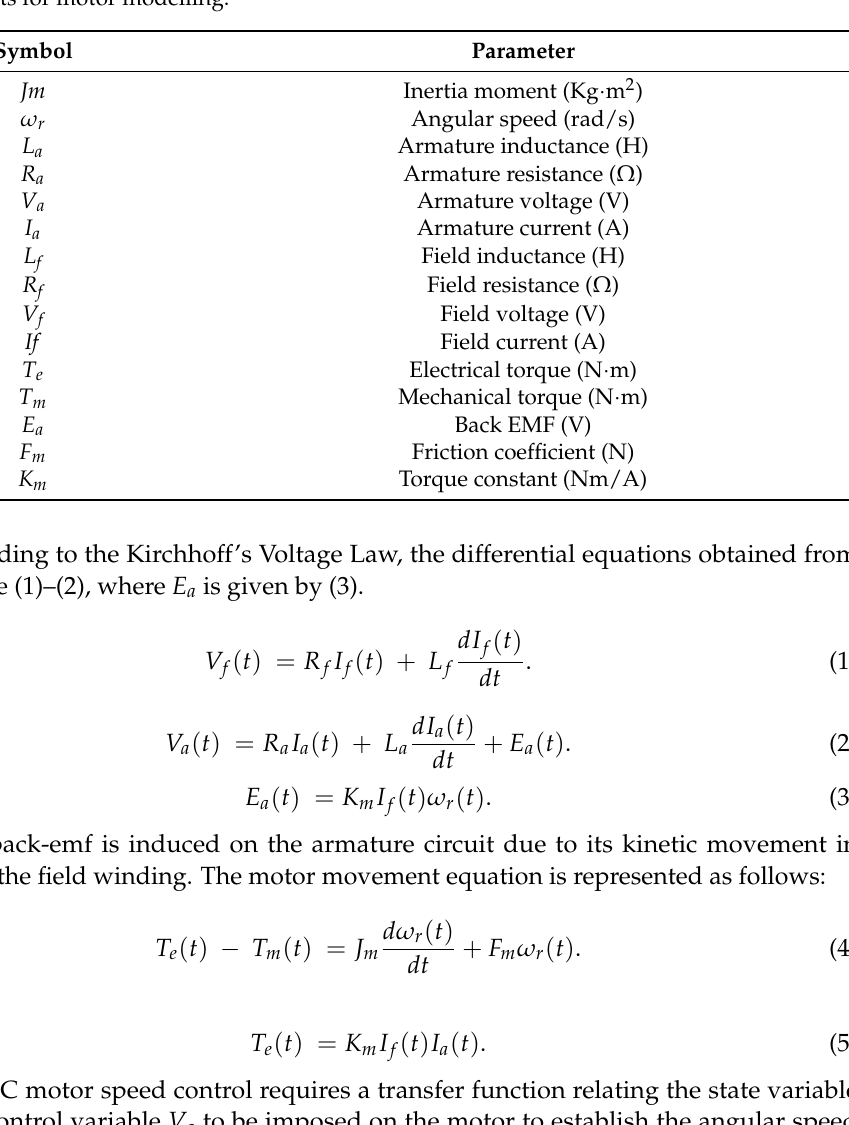
Figure 1. Equivalent circuit of a separately excited DC motor. Table 1. Units for motor modelling.